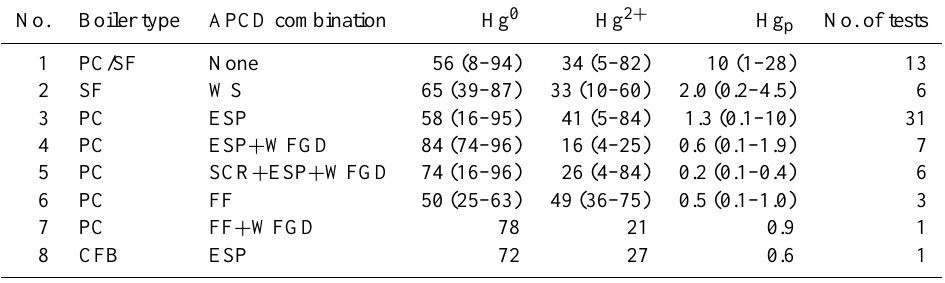
Table 1. Average speciation profiles (ranges) of mercury emissions from coal combustion by boiler type and control technology (%).